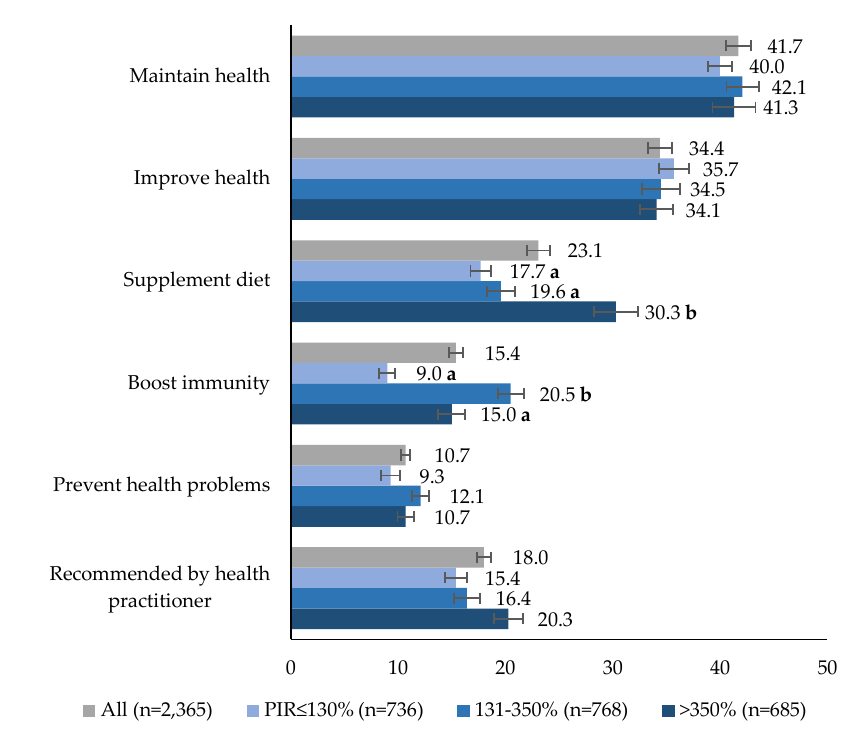
Figure 1. Estimated percentage (%(SE)) of DS users (≤18 years) who had the listed motivations for any dietary supplement use in a 30-day period by family income level, NHANES 2011–2014. PIR, family income-to-poverty ratio. Estimates with different letter subscripts (i.e., a or b) are significantly different across PIR subgroups at p < 0.0167. Participants could select more than one motivation for each product.